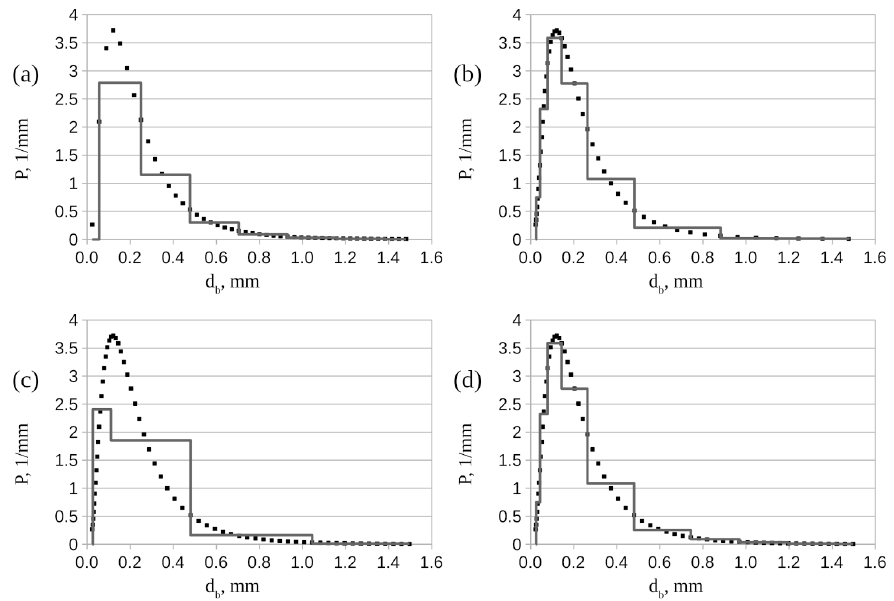
Figure 2. BSD function and piecewise approximations. The characteristic bubble size is d b = 0.25 mm. ( a ) N = 7, R1 ; ( b ) N = 7, R2 ; ( c ) N = 4, R3 ; ( d ) N = 10, R3